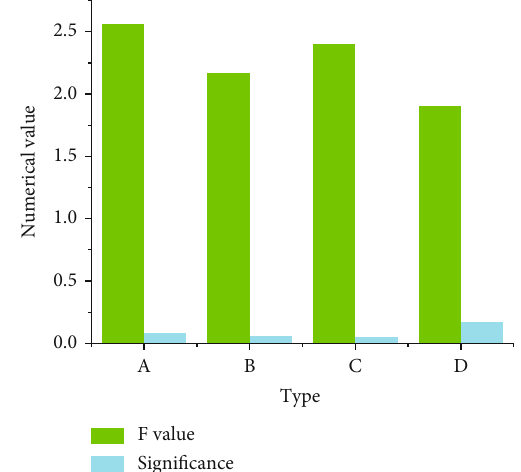
Figure 7: Analysis of variance of the employees ’ education (A: high school education and above; B: associate degree; C: bachelor ’ s degree; and D: master ’ s degree and above).